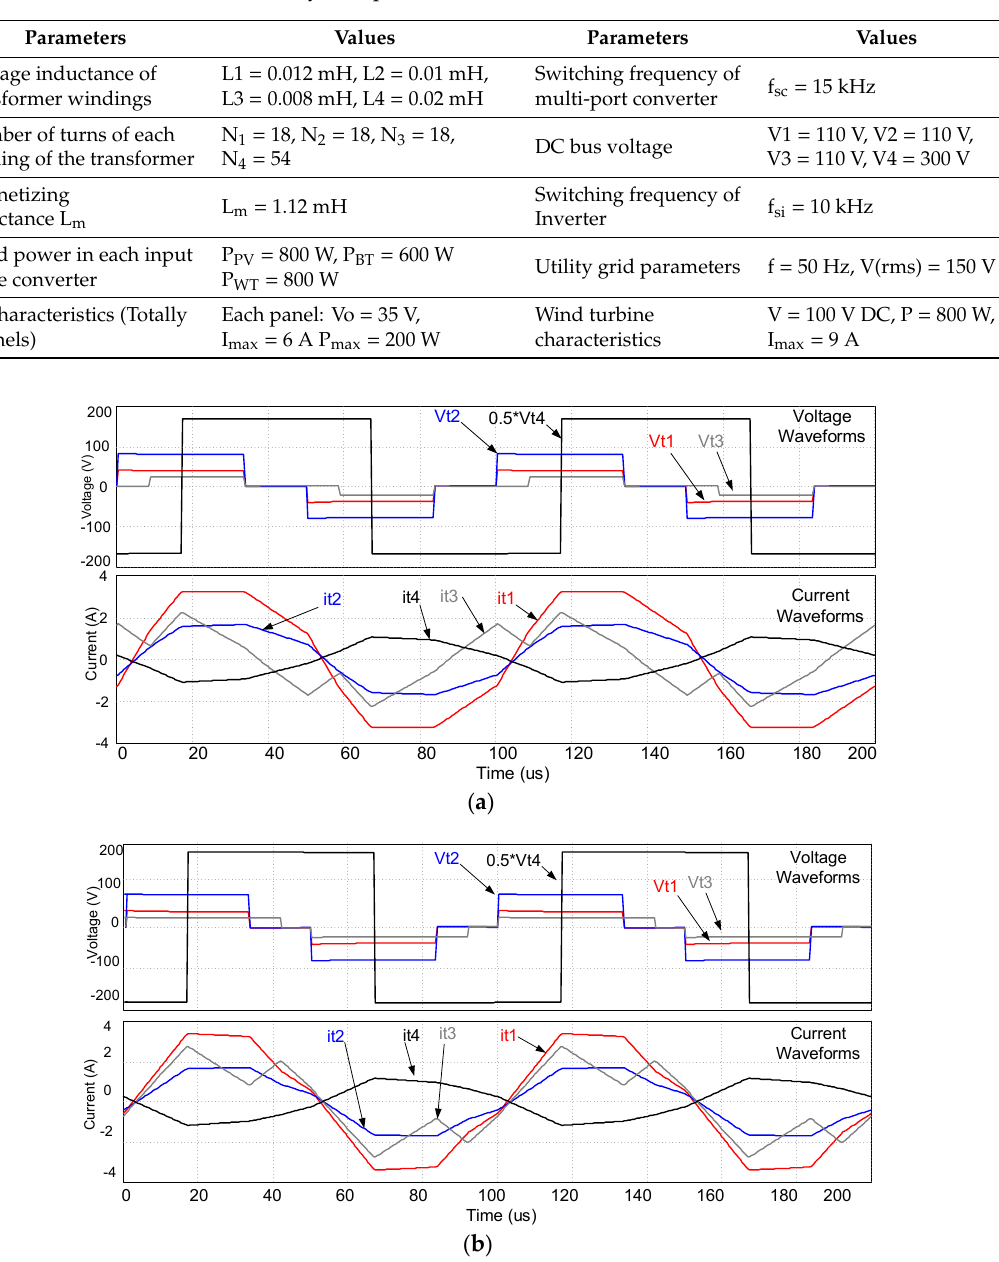
Figure 9. The waveforms of the voltage and current in the multi-winding transformer ( a ) for δ 14 = π /2, δ 24 = π /2, δ 34 = π /2, D 1 = 0.6, D 2 = 0.6, D 3 = 0.4, δ 14 = π /2 and ( b ) δ 14 = π /2, δ 24 = π /2, δ 34 = π /2, D 1 = 0.6, D 2 = 0.6, D 3 = 0.8.